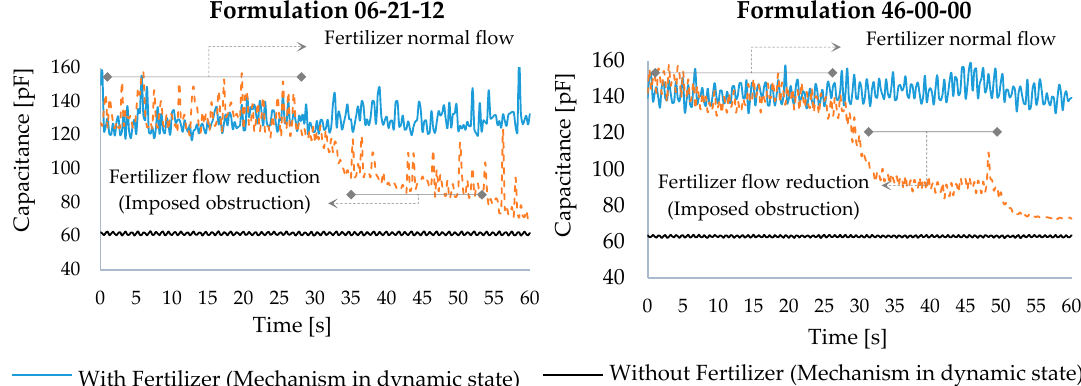
Figure 7. Graphs of the sensor response to the imposition of an obstruction.